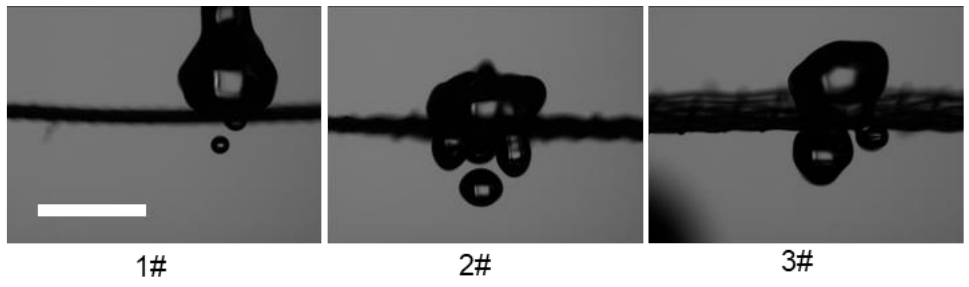
Figure 8. Effect of mesh size on the droplet cutting process. Scale bar is 3 mm.